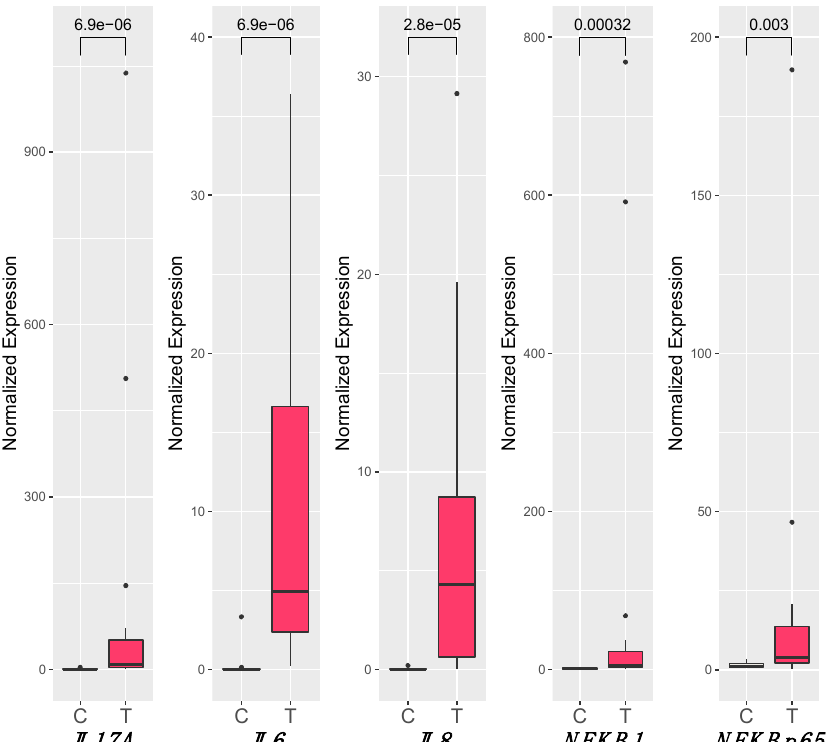
Figure 2. Gene expression levels of IL6 , IL8 , NFKB1 , IL17A , and NFKBp65 . The gene expression levels were normalized to that of the reference B2M , and the Mann–Whitney U -test was used to assess the statistical significance (P < 0.05) of median differences. The statistically significant values among each comparison are shown above the horizontal bar on the upper part of the graph (“e” stands for exponential of ten). C: control group, T: tumor group.